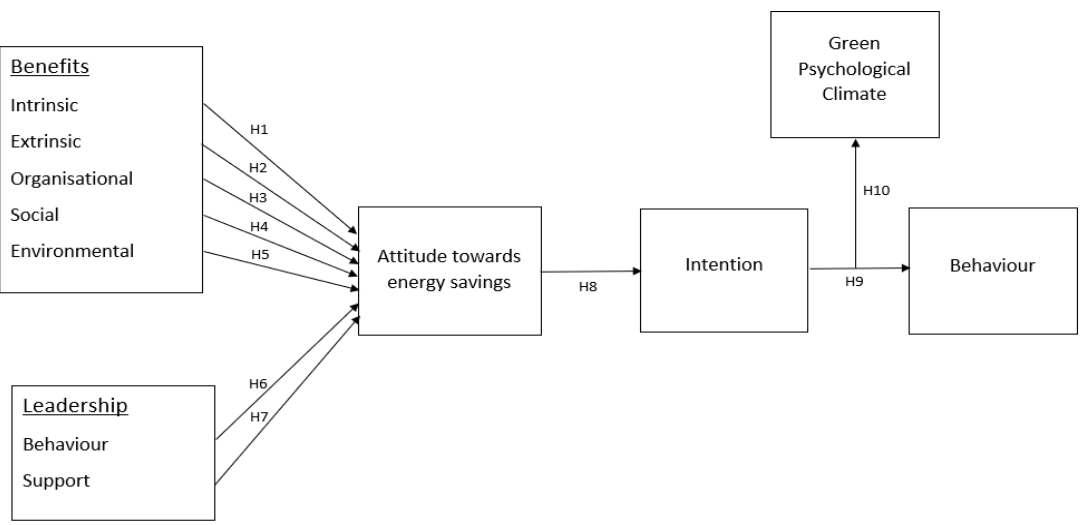
Figure 1. The conceptual model.